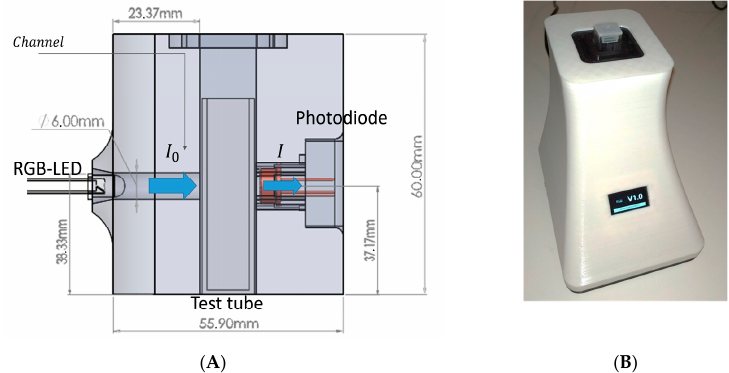
Figure 3. View of the experiment assembly. Schematic view of the assembly. ( A ) Layout diagram of RGB equipment elements. ( B ) Equipment developed for RGB spectrophotometric analysis.